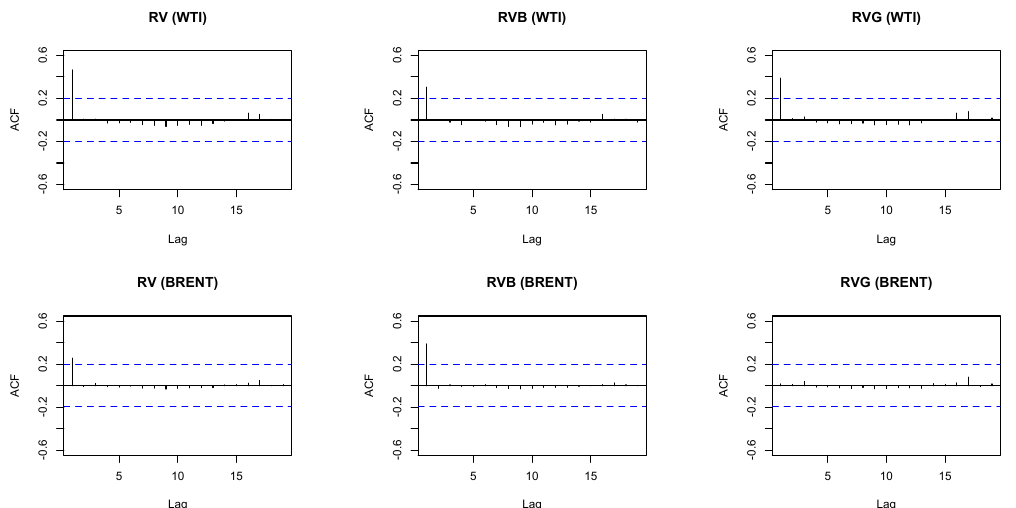
Figure 4. Autocorrelation functions of realized volatility. Dashed horizontal lines: bounds of the 95% confidence interval. RVB : Downside (“bad”) RV . RVG : Upside (“good”) RV